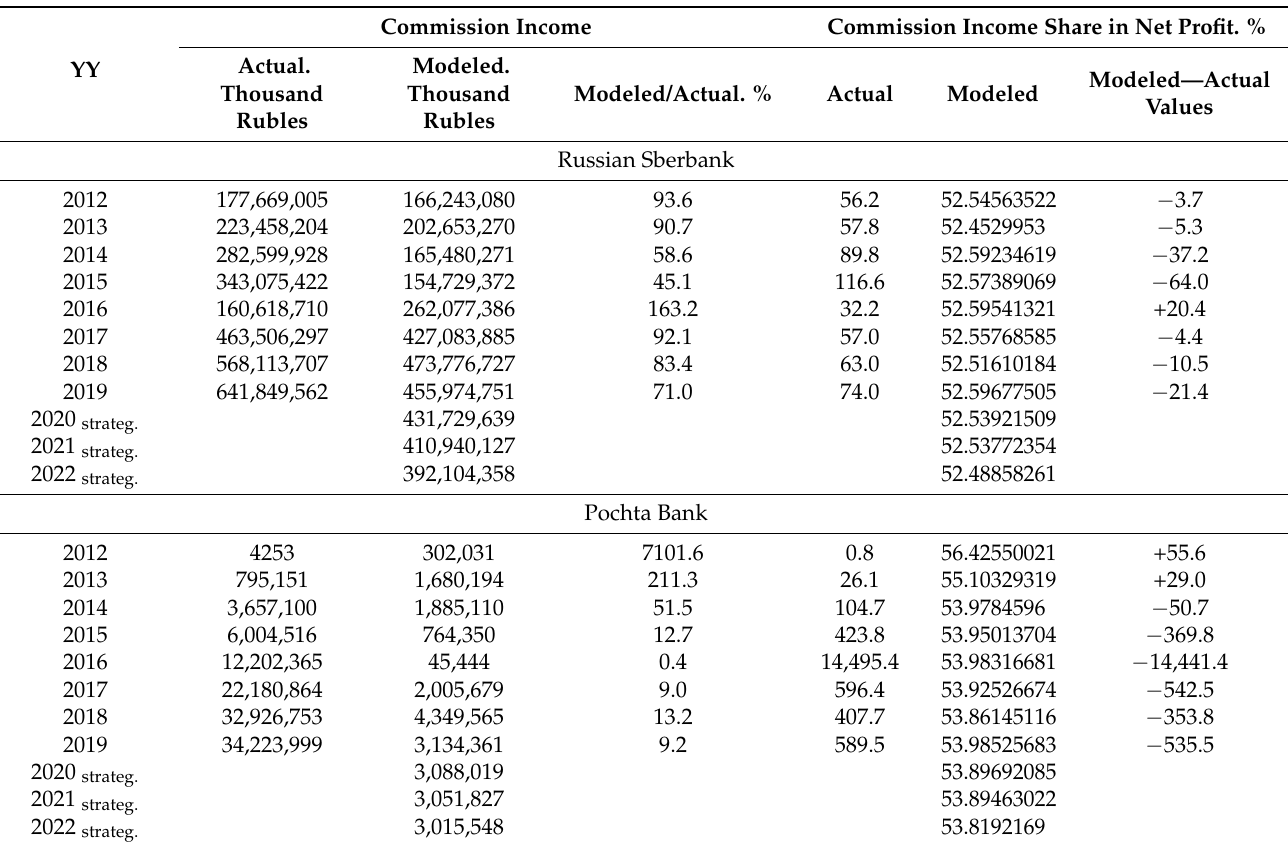
Table 3. Determination of potential strategic innovation risk of banks based on adapted data mining method–Monte Carlo. Commission Income Commission Income Share in Net Profit. % Actual. Modeled. YY Thousand Modeled/Actual. % Actual Modeled Rubles